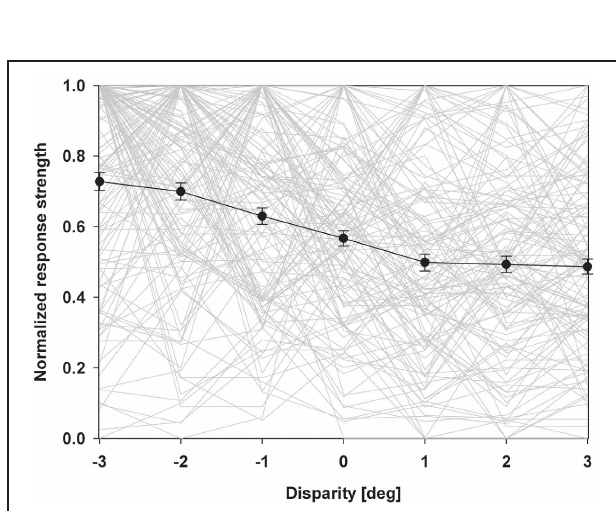
(4) occurred for the stimulus furthest away, i.e., at + 3 ◦ disparity, corresponding to 229cm in front of the monkey. Panel (B) depicts the mean population activity ( ± standard error) taken from all 140 neurons with a significant response to visual stimulus motion and a significant tuning for horizontal disparity.